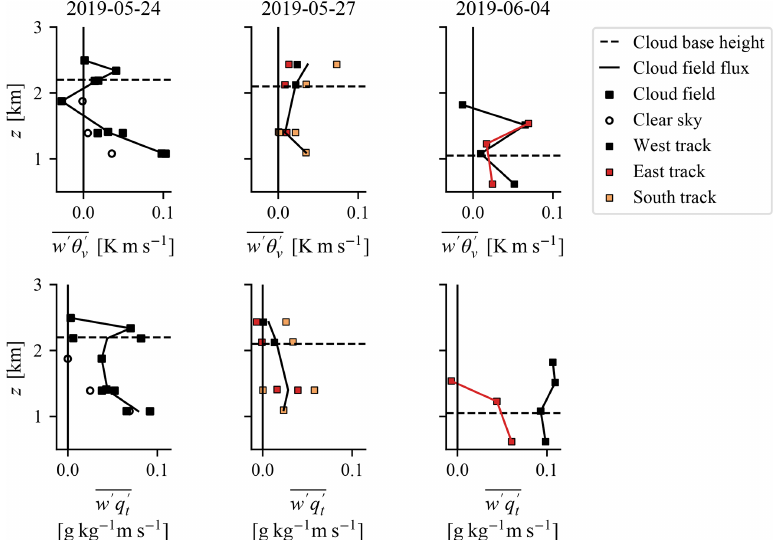
Figure 7. Profiles of buoyancy and the moisture flux for the 3 flight days. On the first flight there were three legs that were partly below clear sky and partly below cloudy sky. They have been separated and are represented by open circles and closed squares, respectively. The other two cases had multiple tracks that are indicated with different colours. The average flux below cloudy skies is indicated by a solid line, of which two are present on the last flight day to show the difference between the western and eastern track. Cloud base is indicated by the horizontal dashed